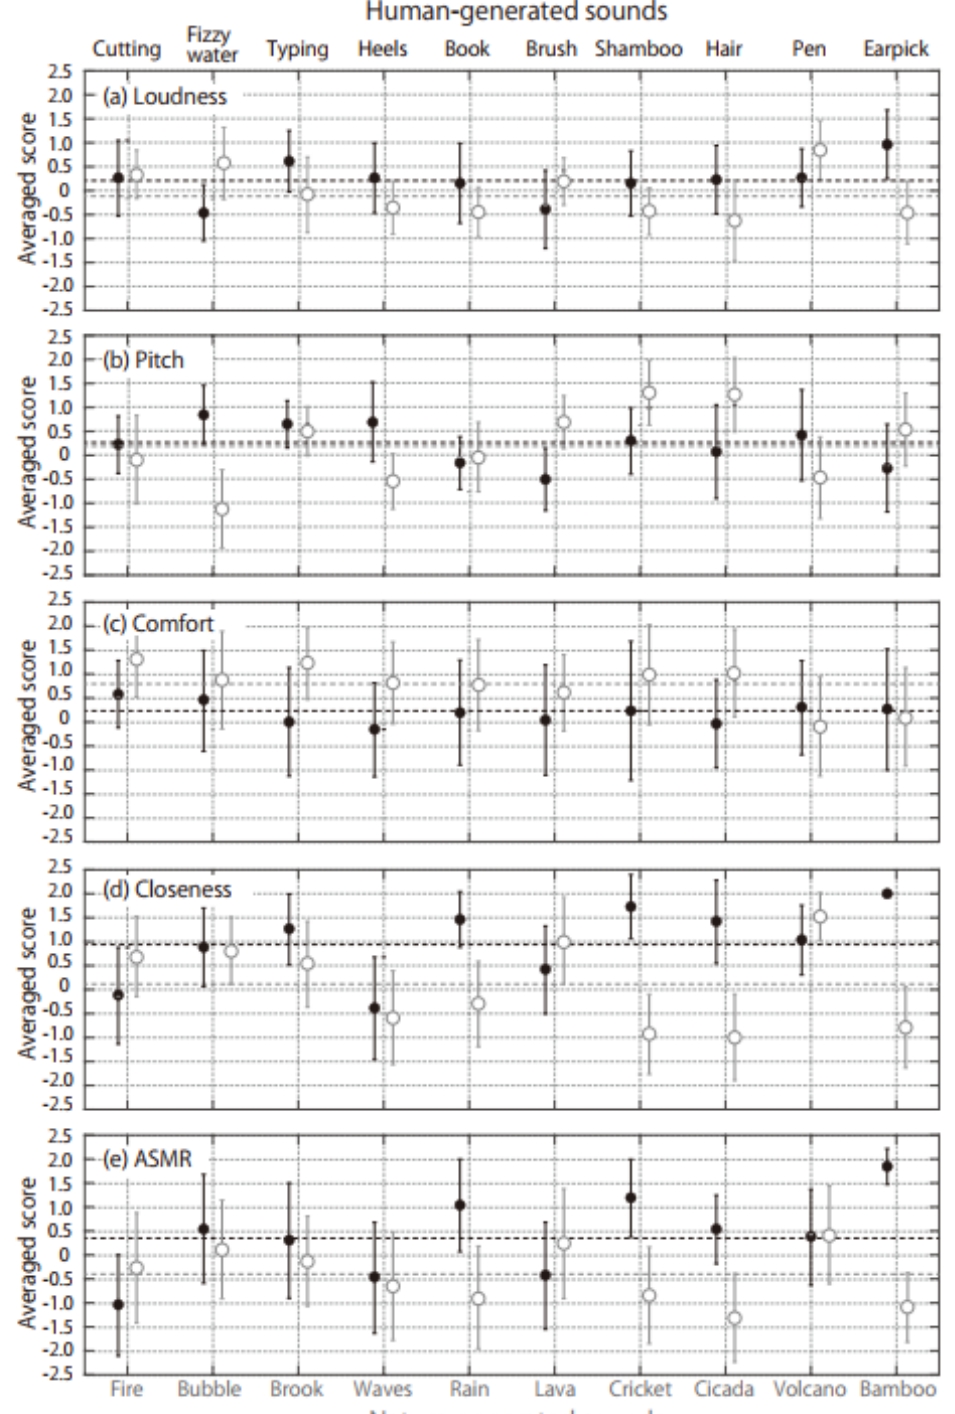
Figure 2. Average scores for ( a ) loudness, ( b ) pitch, ( c ) comfort, ( d ) closeness, and ( e ) the ASMR. Black and gray symbols are results for human- and nature-generated sounds, respectively. The bar on each symbol shows standard deviations. The black and gray horizontal dot lines are total averaged scores for human- and nature-generated sounds, respectively.